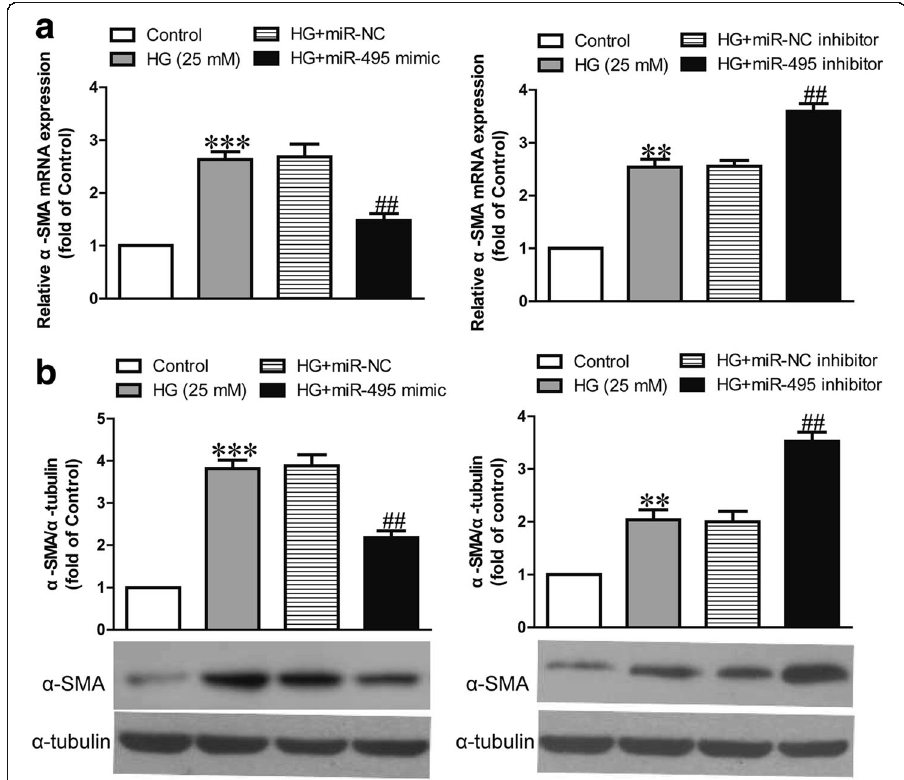
Fig. 3 Effects of miR-495 on high glucose-induced differentiation in human CFs. CFs were transfected with miR-495 inhibitor or mimic for 48 h, and then treated with 5.5 or 25 mM glucose for 24 h. HG + miR-NC indicates CFs transfected with the miR-495 inhibitor before treatment with high glucose; HG + miR-495 mimic indicates CFs transfected with the miR-495 mimic before treatment with high glucose. a and b The mRNA and protein expressions of α -SMA were respectively determined via quantitative RT-PCR and western blot. The data shown are means ± SEM ( n = 6). ** p < 0.01, *** p < 0.001 vs. control; ## p < 0.01 vs. vehicle +